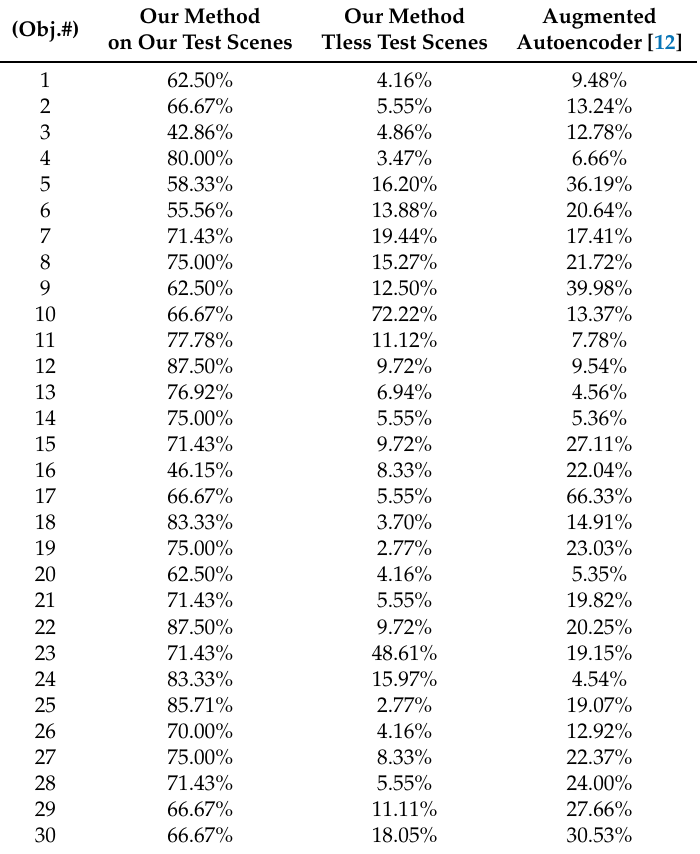
Table 1. Object recall for err vsd < 0.3 on our 30 different test scenes and Primescene test scenes of Tless dataset. Some of our test scenes are shown in Figure